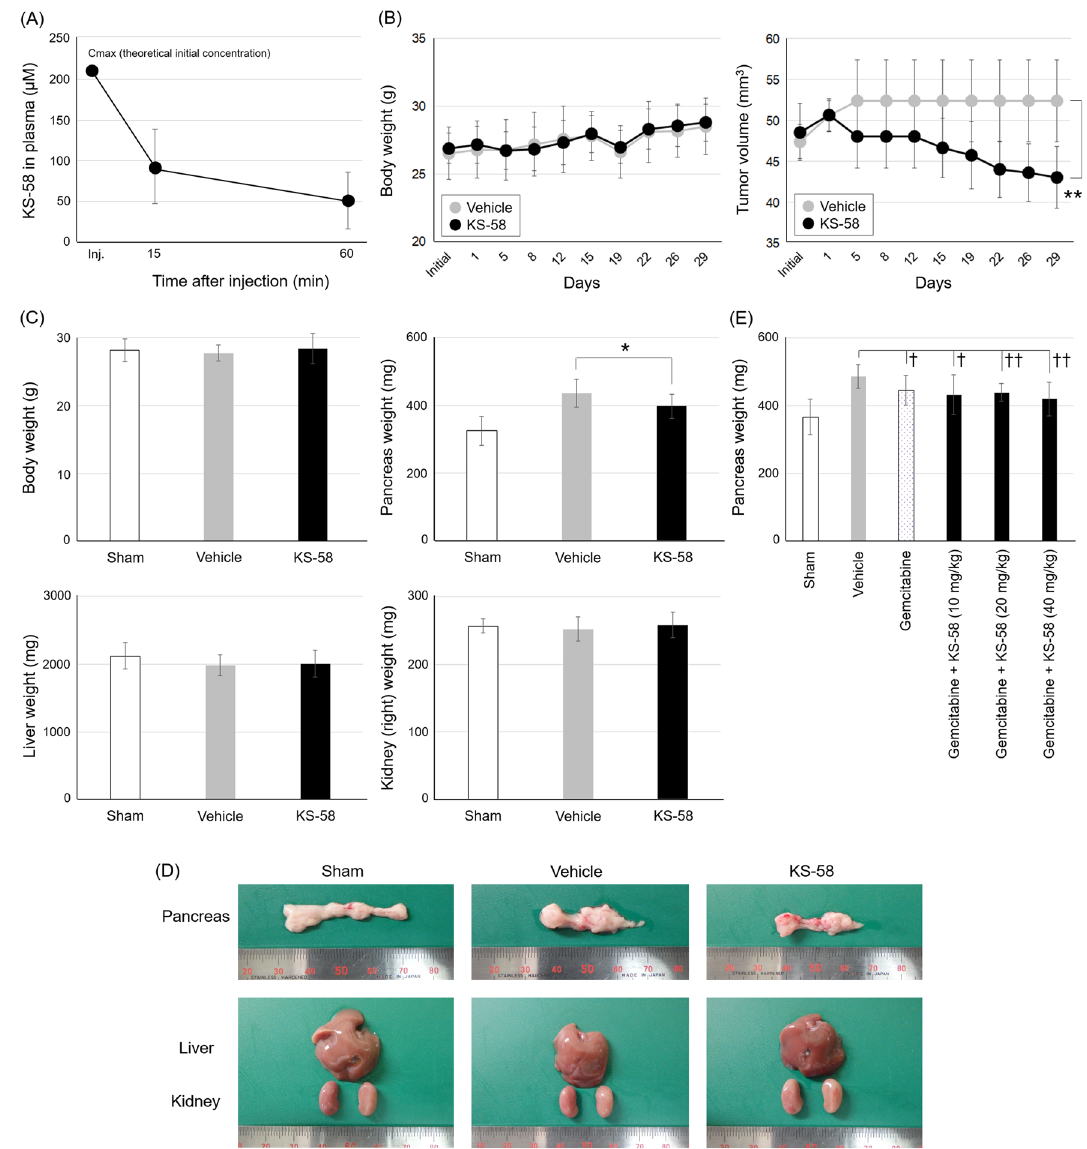
Figure 5. Animal studies using KS-58. ( A ) Pharmacokinetic profile of KS-58 in mice by intravenous injection (20 mg/kg, n = 3, ± SD). C max (theoretical initial concentration) of KS-58 was calculated assuming that the blood volume of mice was 7.3% of body weight. ( B ) In vivo anti-cancer efficacy of KS-58 in mice bearing PANC-1 subcutaneous xenografts (40 mg/kg, n = 4 in vehicle group, n = 10 in KS-58 group). Changes of body weights and tumor volumes are shown (± SD, ** p < 0.005 by Student’s t -test). ( C ) In vivo anti-cancer efficacy of KS-58 in mice bearing PANC-1 orthotopic xenografts (40 mg/kg, n = 7 in each group). Body weight and organ weight (pancreas, liver, and right kidney) are shown (± SD, * p < 0.05 by Student’s t -test). ( D ) Representative appearance of each organ of mice in orthotopic xenografts experiments. ( E ) Combination administration test of KS-58 and gemcitabine (n = 10 in each group). Pancreas weight is shown (± SD, † p < 0.025 and †† p < 0.005 by Williams’